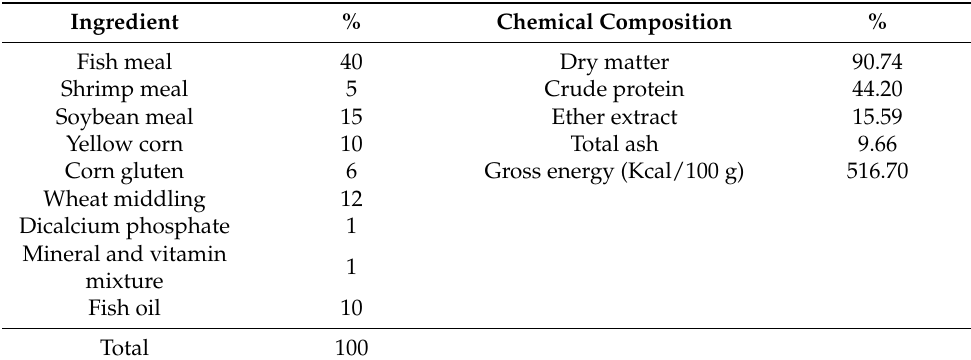
Table 1. Formulation and chemical composition of the basal diet.